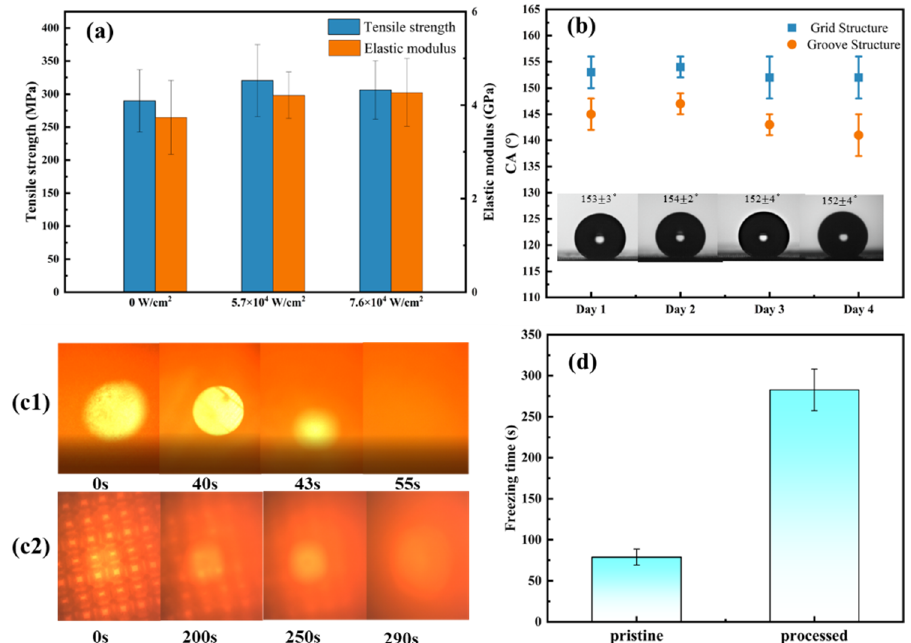
Figure 7. ( a ) Mechanical properties comparison among pristine and 80 µ m grid processed by 5.7 × 10 4 W/cm 2 and 7.6 × 10 4 W/cm 2 laser power density; ( b ) surface contact angle test over 4 days on 80 µ m grid and groove patterns; ( c ) CCD camera records of the freezing process of the pristine ( c1 ) and 80 µ m grid sample processed by 5.7 × 10 4 W/cm 2 ( c2 ) and ( d ) the corresponding freezing time comparison between pristine and processed at the temperature of − 10 ◦